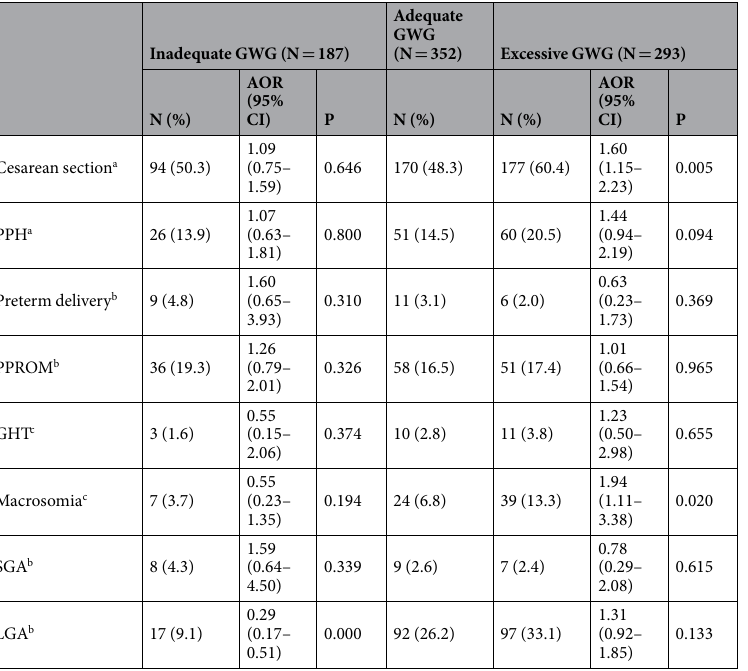
Table 4. Effects of gestational weight gain on pregnancy outcomes. AOR, adjusted odds ratio; BMI, body mass index; CI, confidence interval; GWG, gestational weight gain; PPH, postpartum hemorrhage; PPROM, preterm premature rupture of membranes; GHT, gestational hypertension; SGA, small for gestational age; LGA, large for gestational age. AORs are presented relative to the adequate GWG group. a Adjusted for maternal age, gestational weeks, pre-pregnancy body mass index and birth weight; b adjusted for maternal age and pre-pregnancy body mass index; c adjusted for maternal age, gestational weeks and pre-pregnancy body mass index.